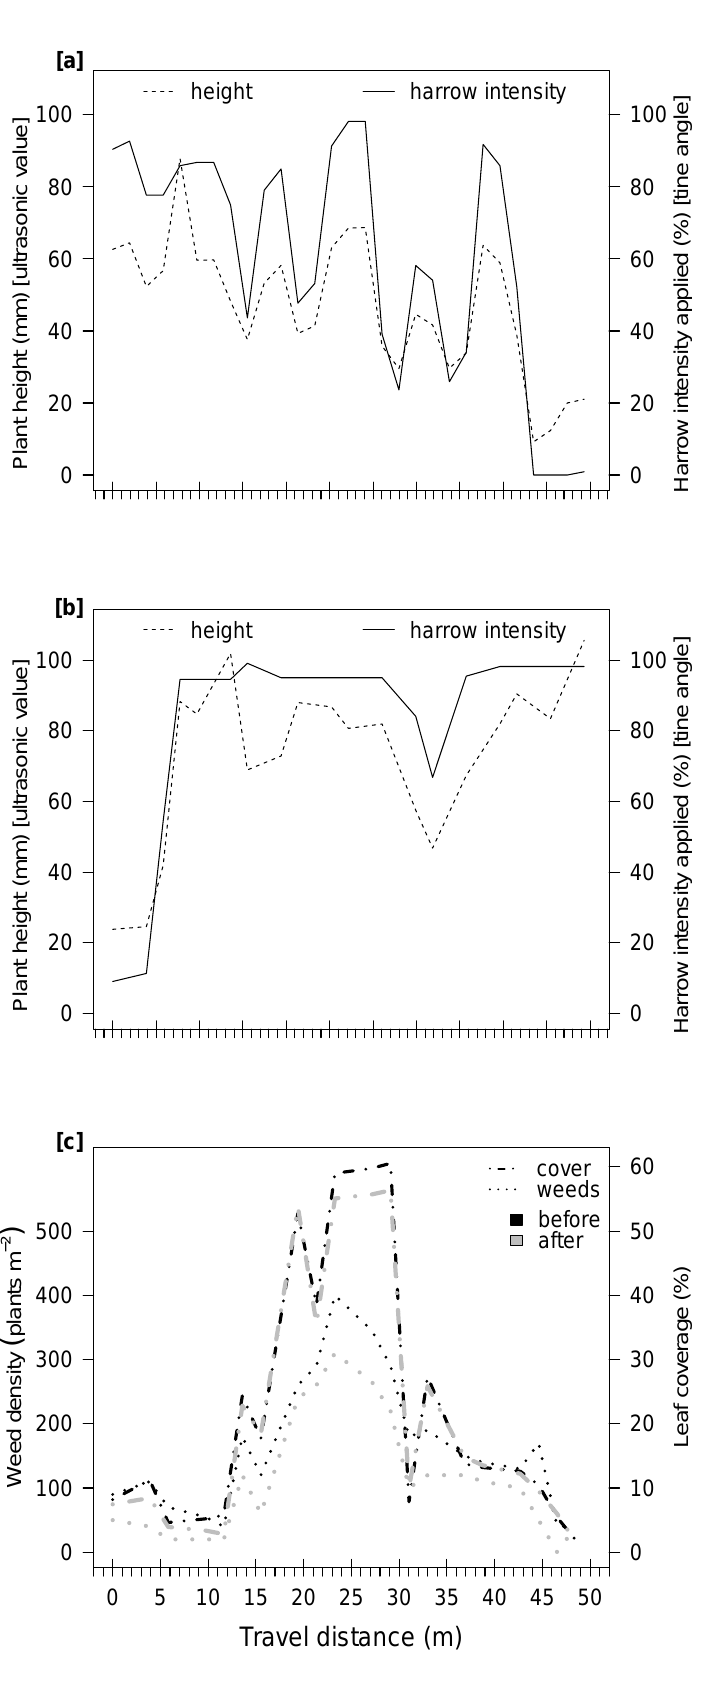
Figure 5. Ultrasonic value of plant height and harrowing intensity applied by the control unit in experimental plot B, first pass ( a ) and second pass ( b ); and variation in weed density and leaf cover before and after harrowing ( c